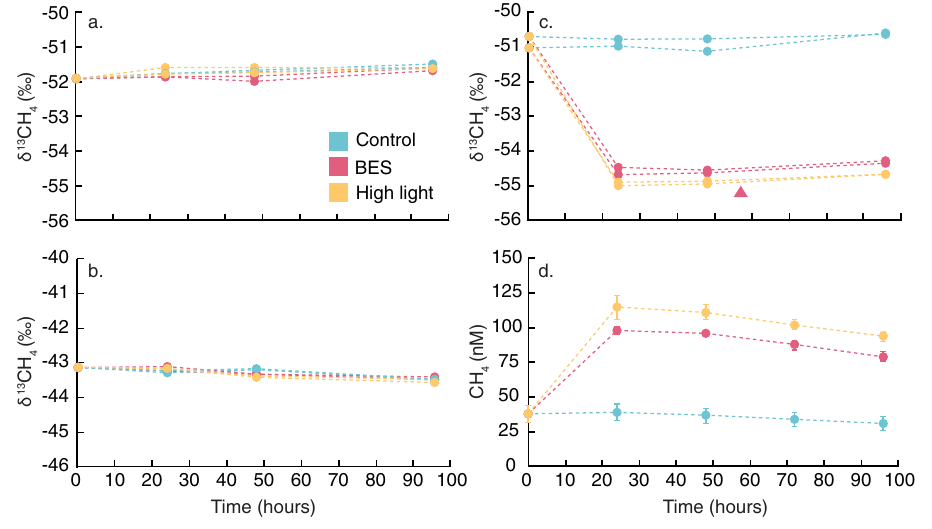
Fig.3| δ 13 CH 4 andCH 4 inexperimentaltreatments. δ 13 CH 4 valuesareshownover time forduplicate samplescollected during the (a)L7, (b)LG6, and c UC4 and UC3 experiments. d CH 4 concentrations are shown over time in the UC4 experiment. Different colors denote different experimental treatments and controls (BES indi- cates the addition of the methanogenesis inhibitor 2-bromoethanesulphonate).